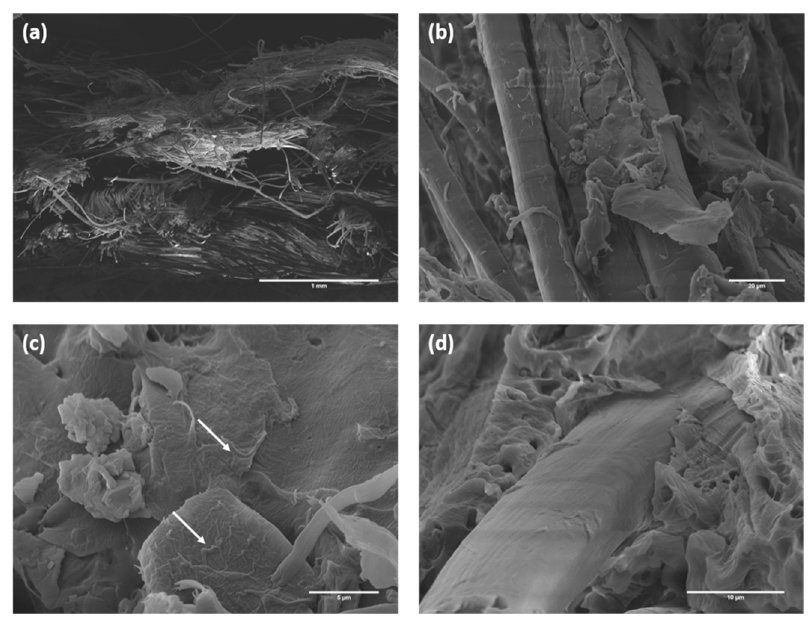
Figure 8. SEM micrographs of the fracture surfaces of PP/Flax_GNP composites at different Figure8. SEMmicrographsofthefracturesurfacesofPP / magnifications.